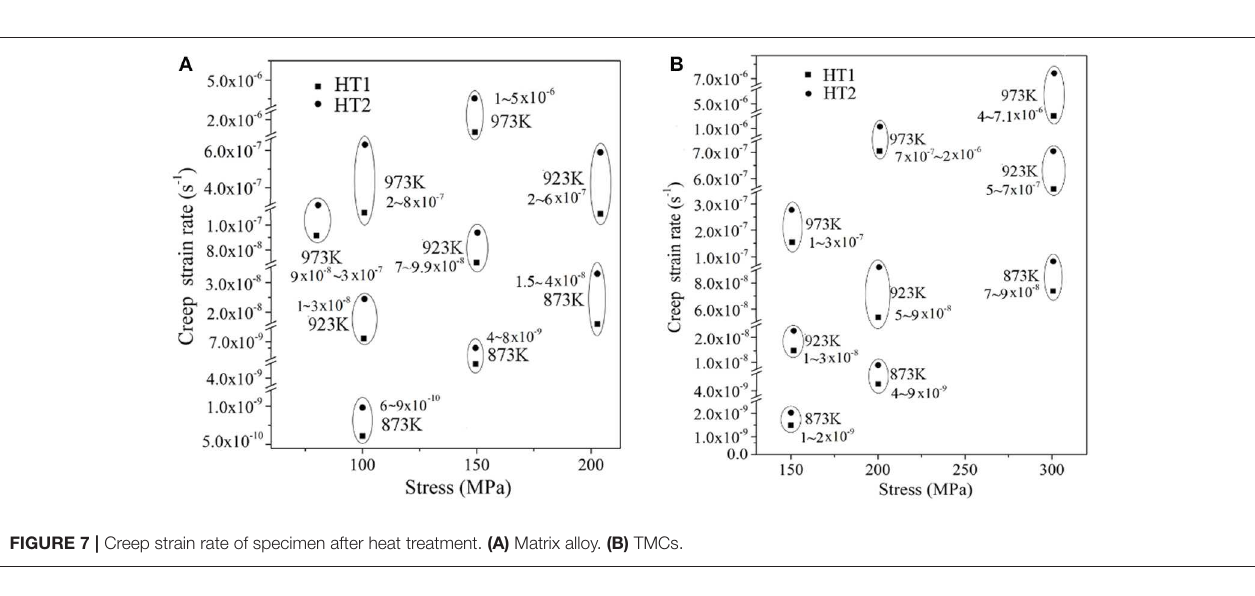
So, the creep resistance of HT2 is much lower. The α +